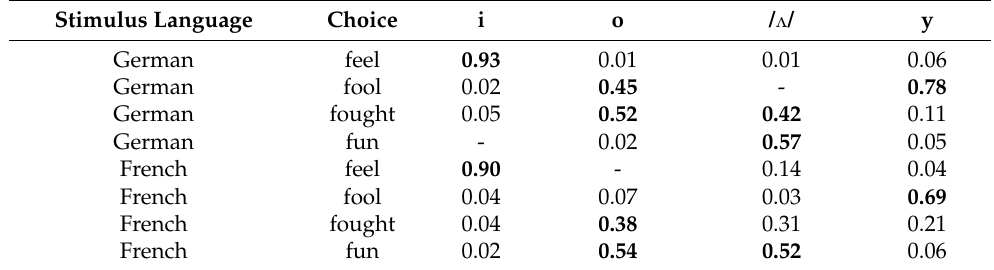
Table 2. The percentage of categorizations of phonemes in the English monolinguals group. Stimulus Language